Question: Write a caption explaining this figure to a reader.
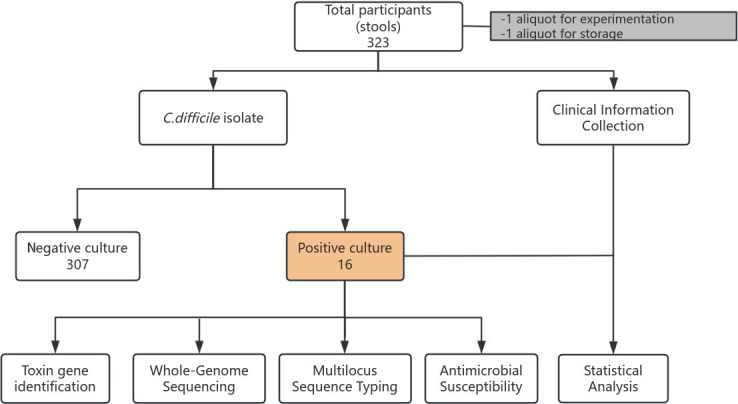
Answer: Susceptibility-toxin genotype correlation in 16 clinical C. difficile isolates